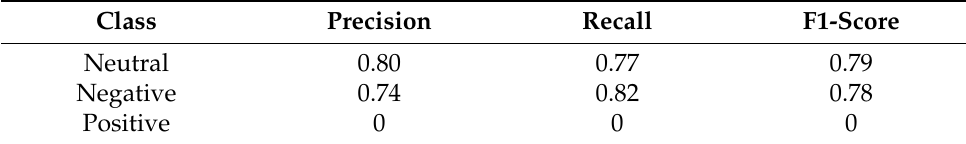
Table A2. Random Forest evaluation.